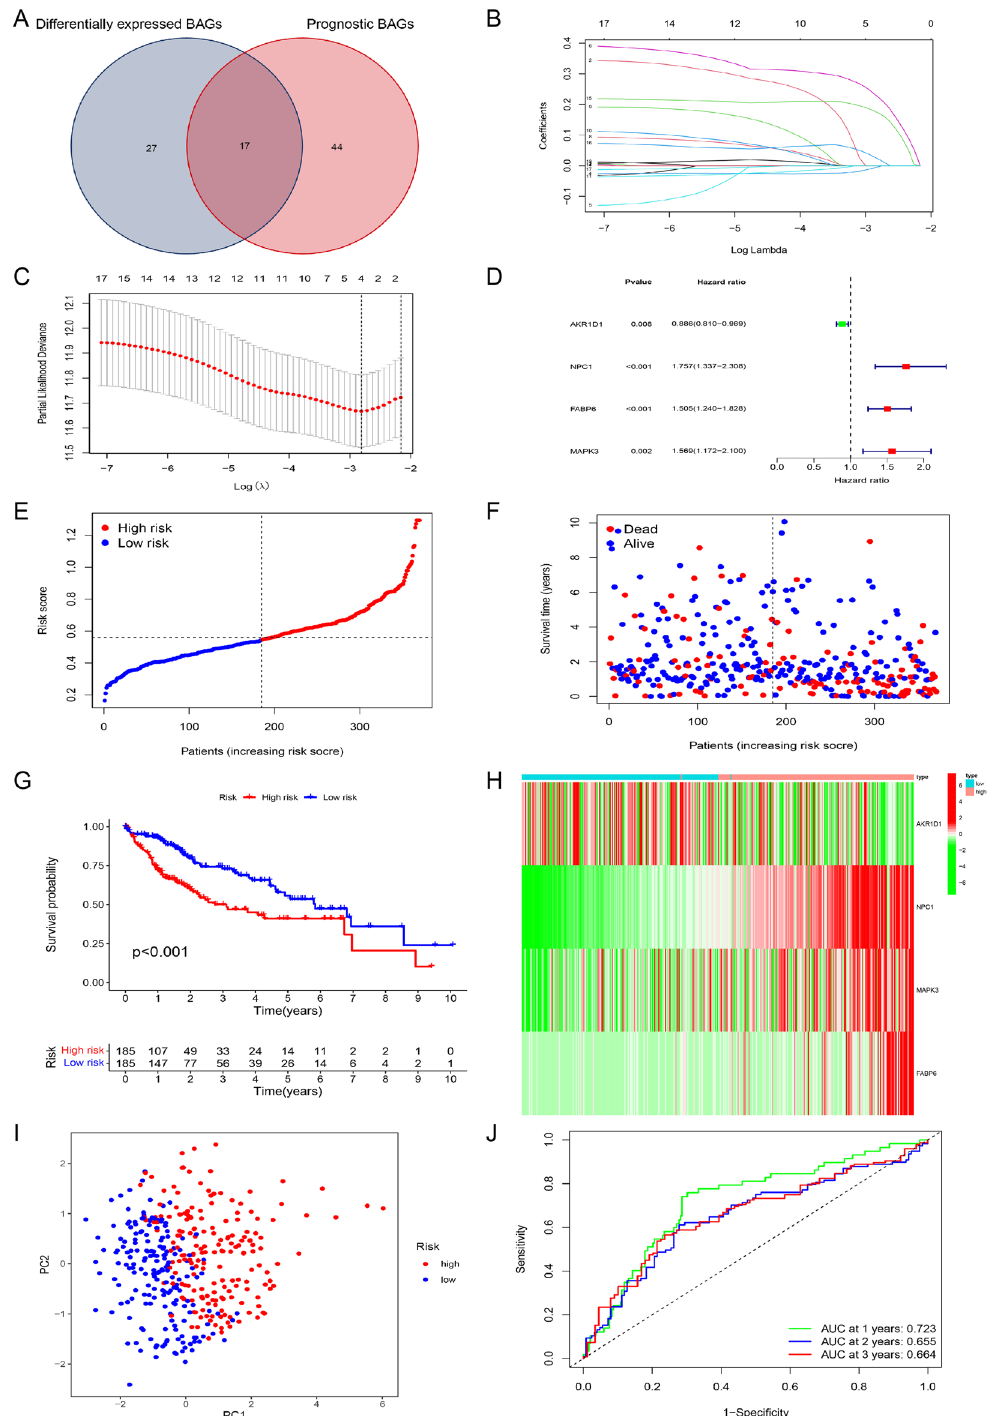
Figure 2. Construction of the bile acid-related risk signature in TCGA cohort. ( A ) Venn diagram displaying 17 intersecting genes between the 44 differentially expressed BAGs and 61 prognostic BAGs. ( B ) LASSO regression analysis of 17 differentially expressed prognostic BAGs. ( C ) Cross-validation of LASSO regression analysis. ( D ) Forest plot of modeling genes. ( E ) Risk grouping based on median risk value. ( F ) Relationship between risk value and survival status. ( G – I ) KM curve, expression of modeling genes and PCA based on risk grouping. ( J ) ROC curves in TCGA